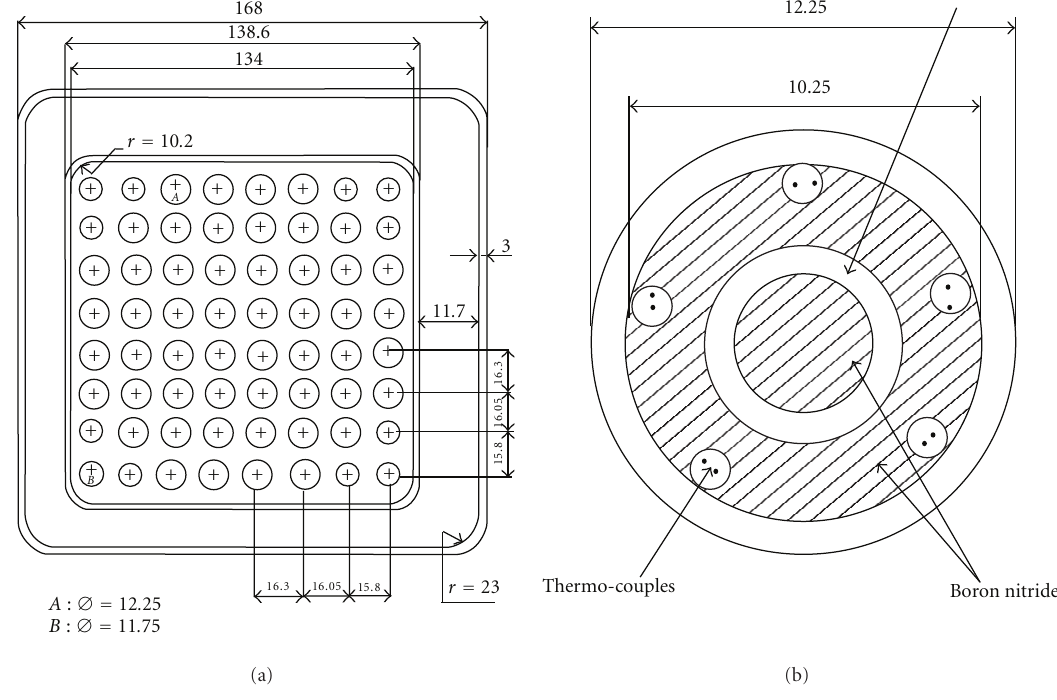
Figure 3: Cross-sections of the bundle and the heater